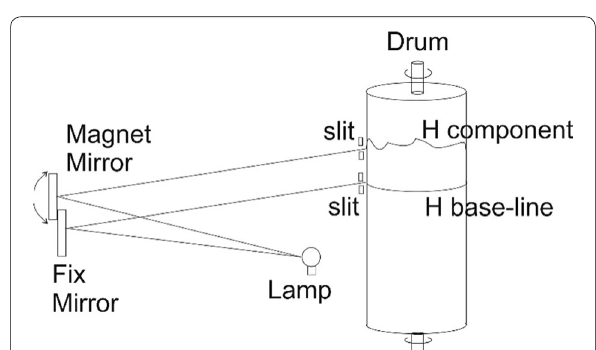
Fig. 12 Diagram of the principle setup of a classical variometer